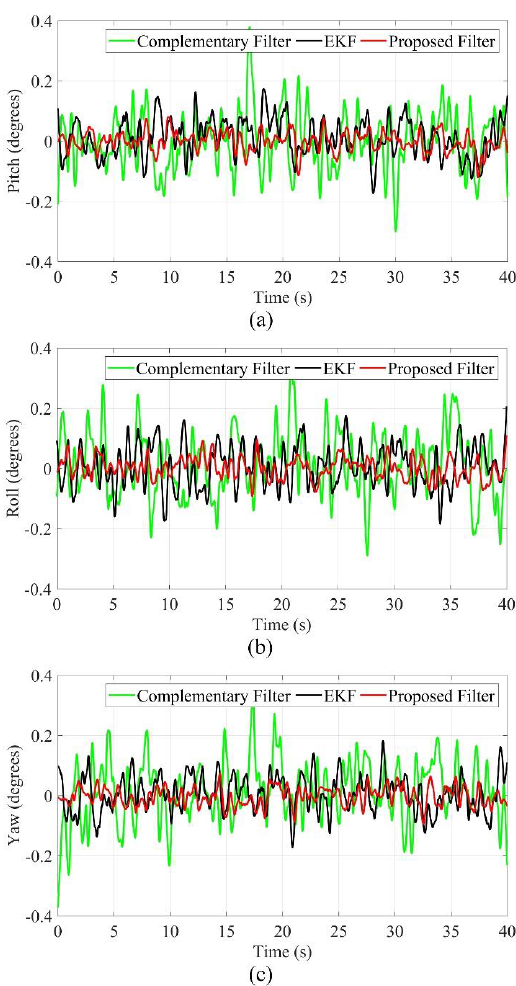
Figure 11. Static test ( a ) pitch angle; ( b ) roll angle; ( c ) yaw angle. Sensors 2019 , 19 , x FOR PEER REVIEW